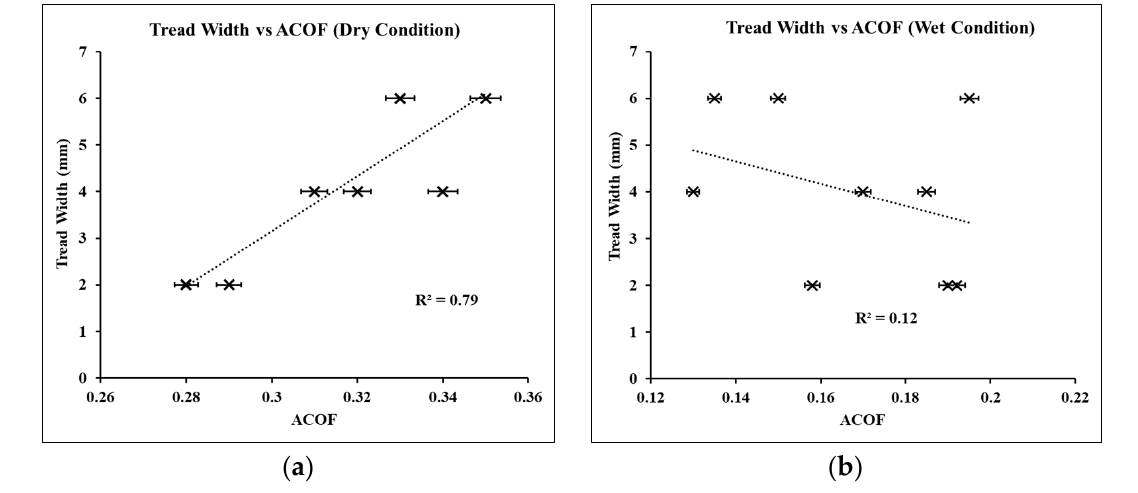
Figure 10. Effect of tread width on ACOF in: ( a ) dry conditions and ( b ) wet conditions.